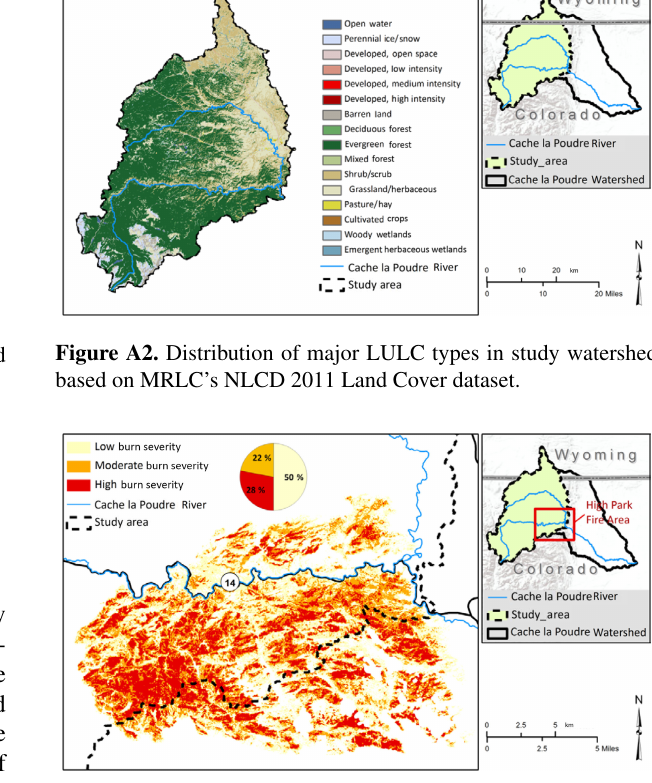
Figure A3. Distribution of burn severity of the Hewlett and High Park wildfires within the study watershed based on MTSB’s High Park Wildfire